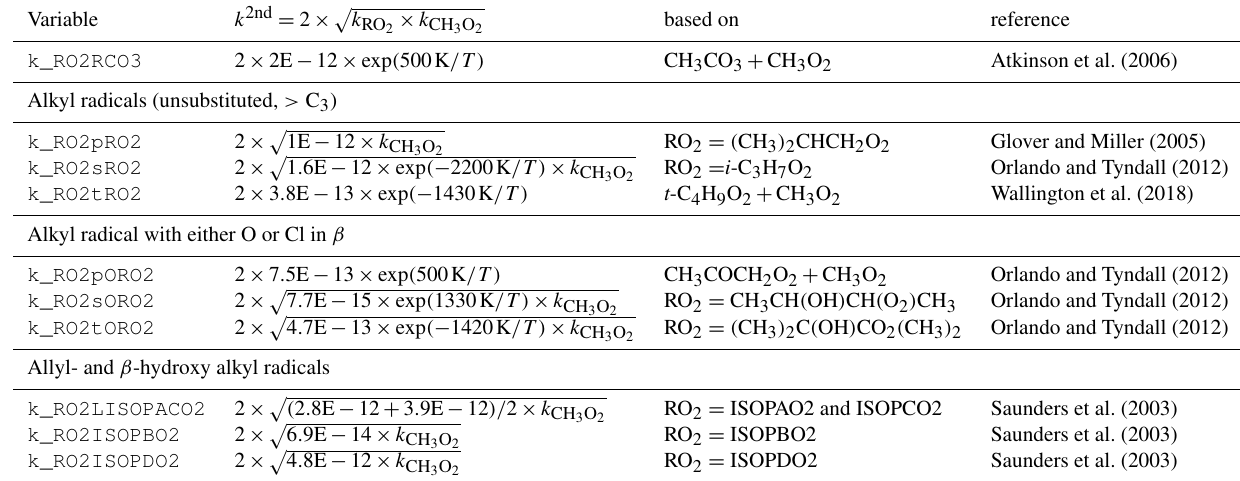
Table 2. Second-order rate constants k 2nd for permutation reactions (in cm − 3 s − 1 ). Here, k CH is for the self reaction of CH 3 O 2